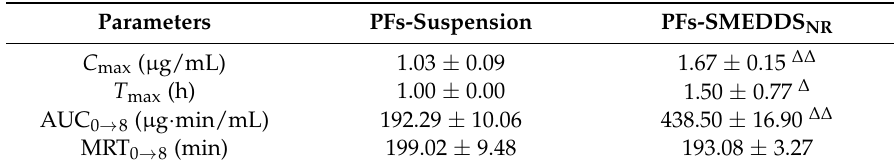
Table 2. Pharmacokinetic parameters of oral administration in cycloheximide-pretreated rats at a dose of 116 mg/kg PFs ( n = 5).